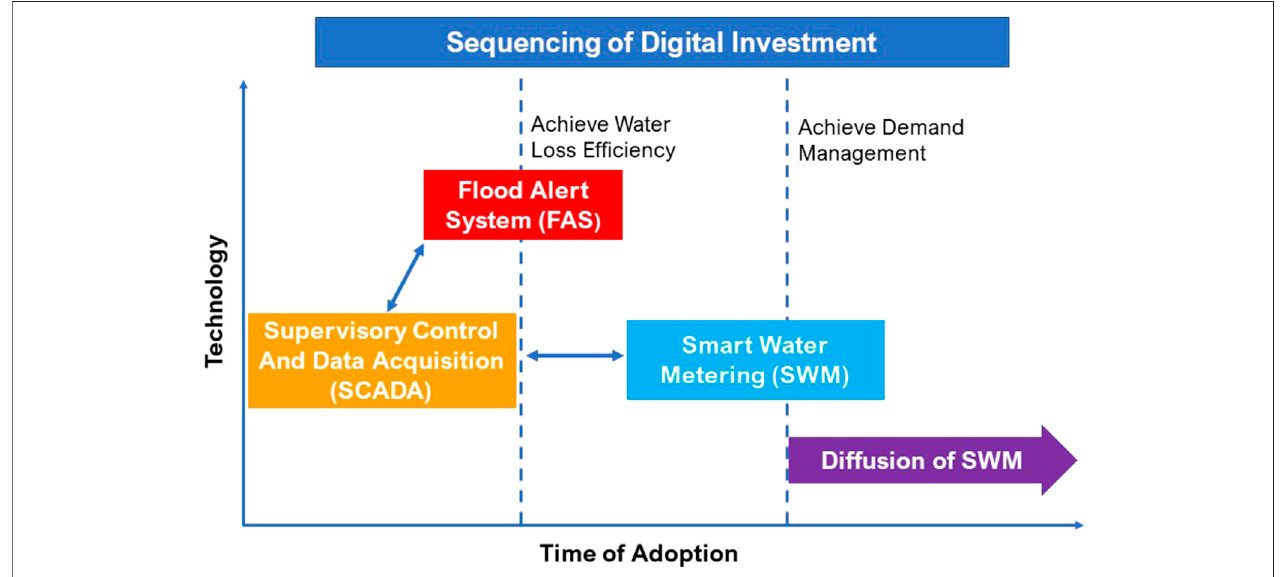
FIGURE 3 | Illustration showing the recommended sequence of adoption and implementation of digital technologies studies here, viz., smart water metering, SCADA system and fl ood alert system.